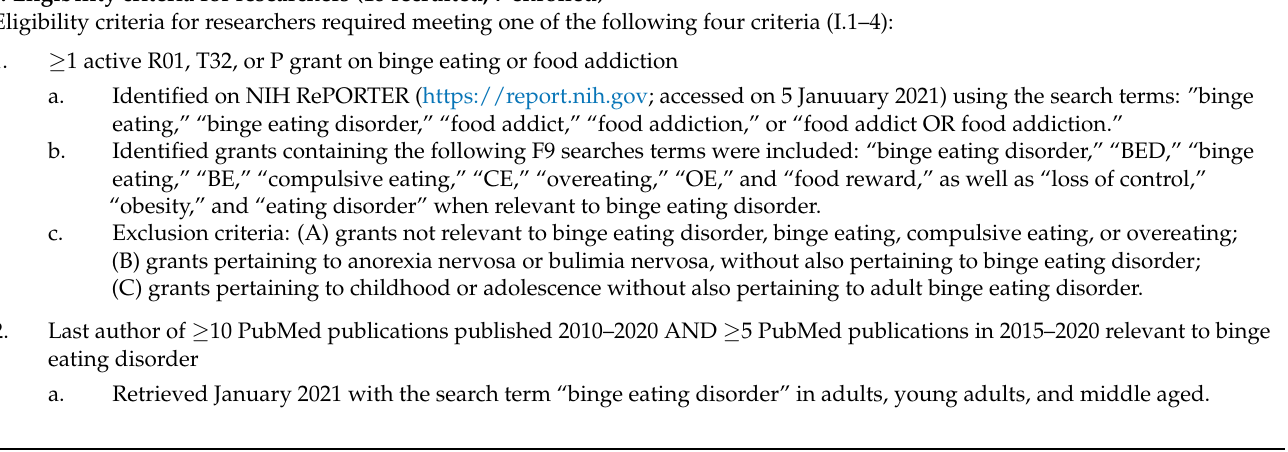
Table 1. Participant eligibility criteria and number of participants who were recruited, and who consented and